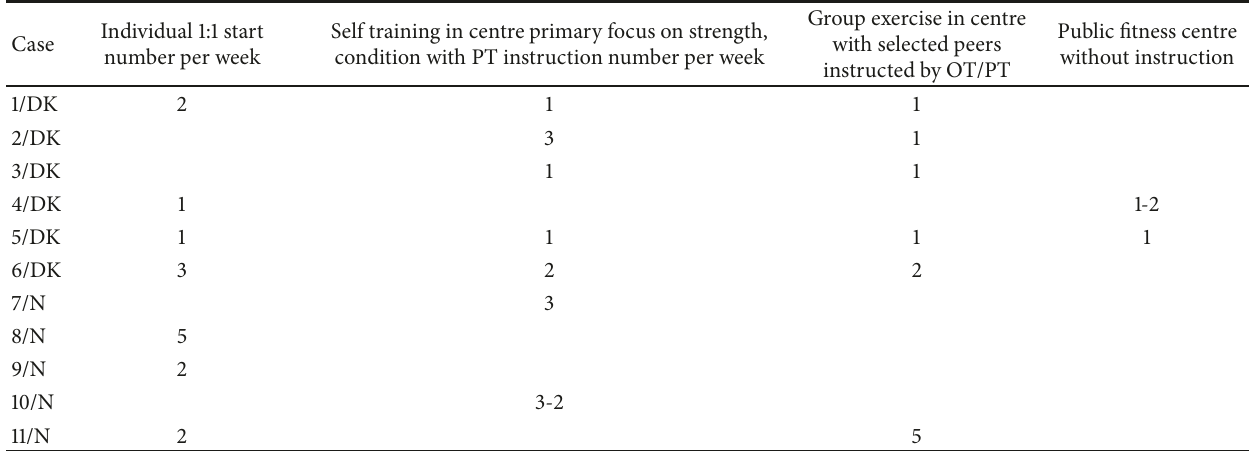
Table 2: Physiotherapeutic contributions in the eleven cases during